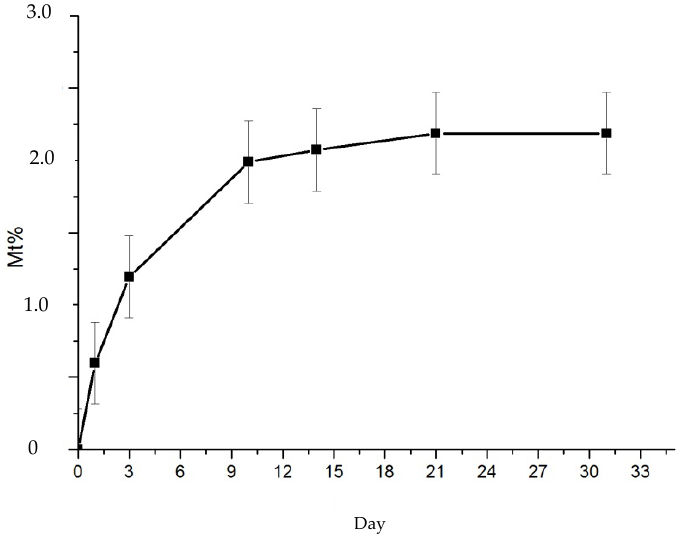
Figure 15. Trend of mass change for thin film at 1000 rpm with 0.25% GNP .